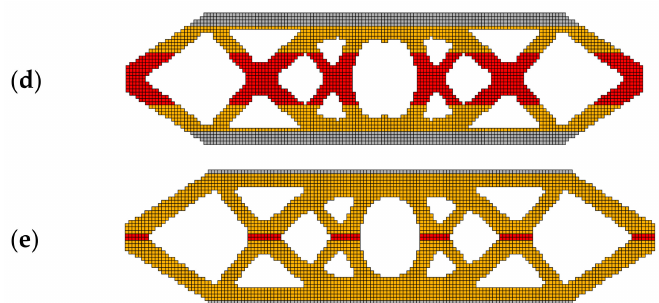
Figure 13. The final topologies generated for the rectangular structure for the 6 distributions of materials: E 1 = 10 11 Pa and E 2 = 2 × 10 11 Pa, indicated in Figure 6. SIMP interpolation scheme: ( a ) one material structure, E 1 —red color, minimal compliance: 14.624 × 10 − 4 Nm; ( b ) two materials structure: E 1 —red color, E 2 —gray color, minimal compliance: 10.506 × 10 − 4 Nm; ( c ) two materials structure: E 1 —red color, E 2 —gray color, including 4 layers of FGM interface—yellow color, minimal compliance: 10.110 − 4 Nm; ( d ) two materials structure: E 1 —red color, E 2 —gray color, including 8 layers of FGM interface—yellow color minimal compliance: 9.748 × 10 − 4 Nm; ( e ) FGM structure: E 1 —red color, E 2 —gray color, FGM—yellow color, minimal compliance: 9.338 × 10 − 4 Nm.